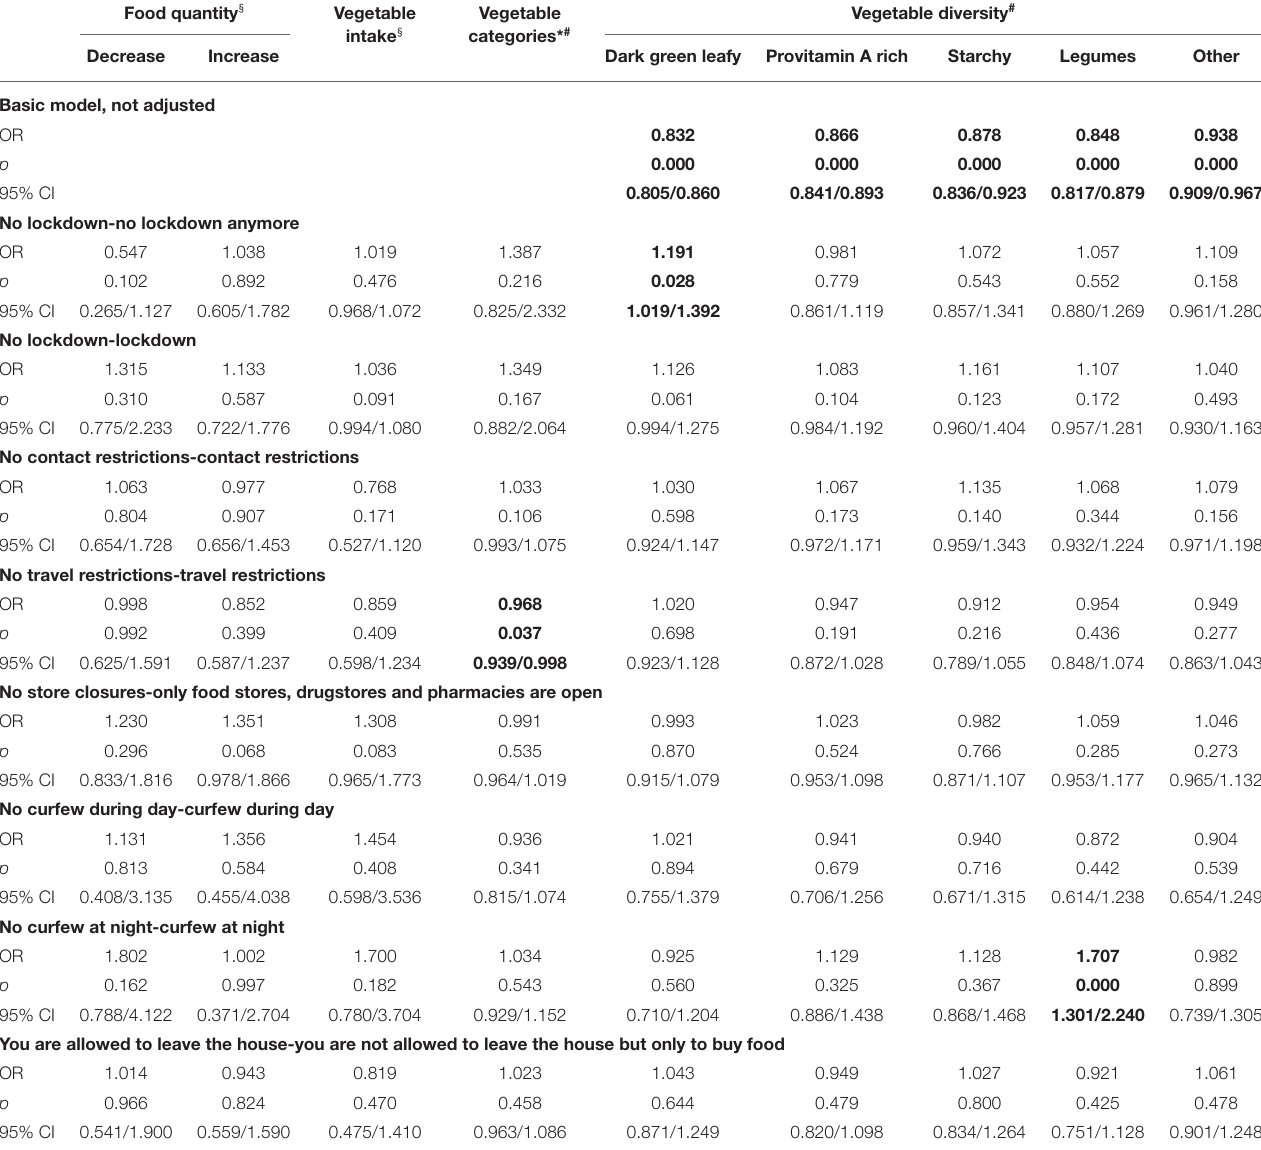
TABLE 3 | Odds ratios for perceived changes in food and vegetable intake. Food quantity § Vegetable intake